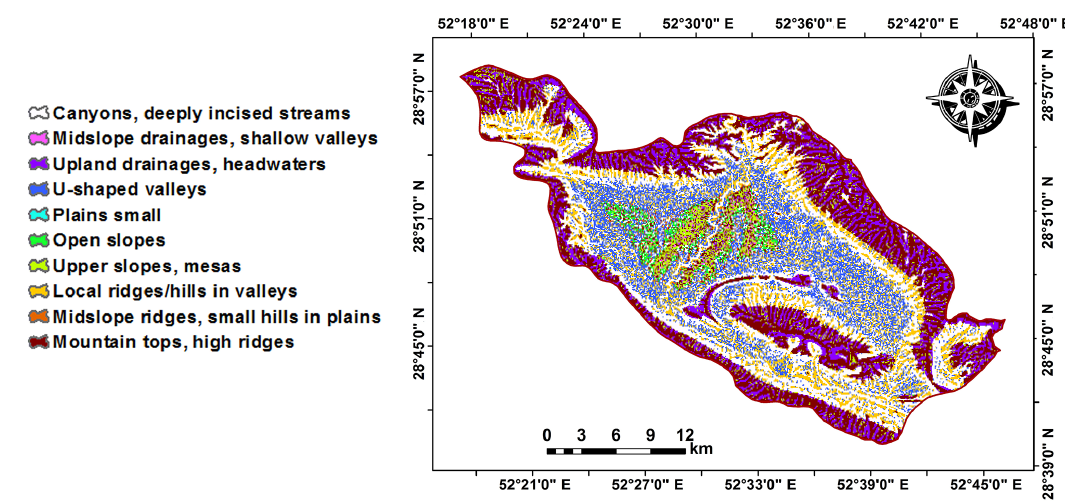
Figure 9. Landform classification using the TPI